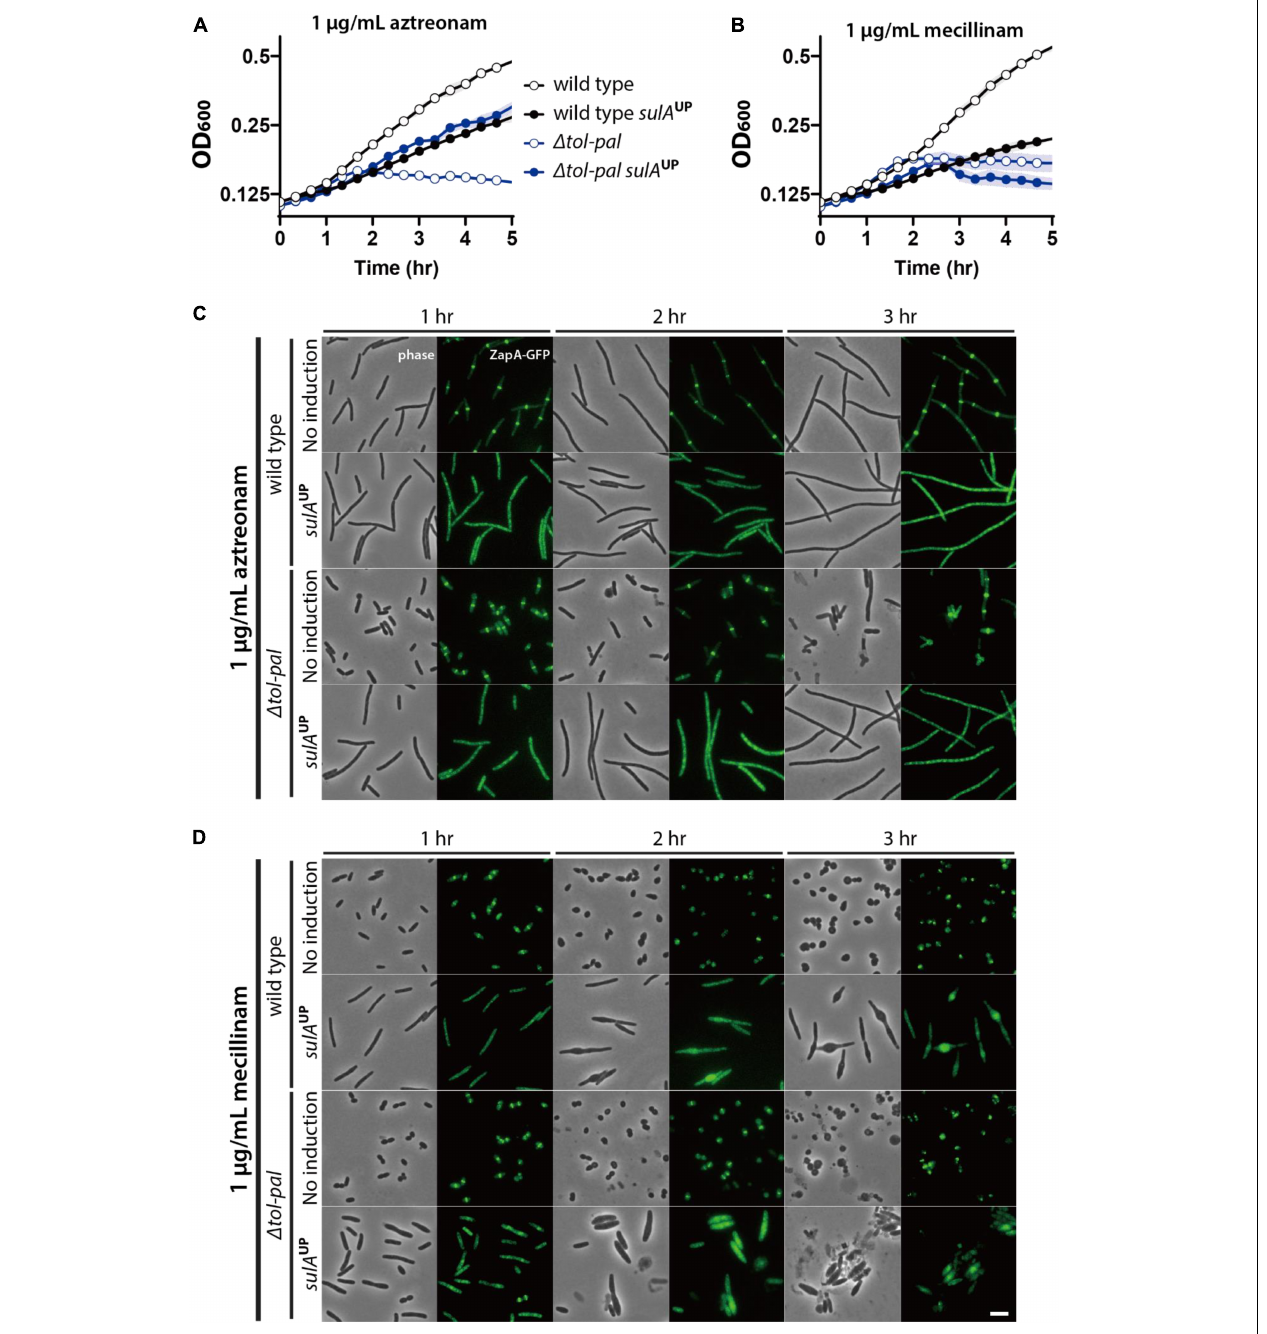
FIGURE 4 | Accelerated lysis of the tol-pal mutant upon mecillinam treatment is not suppressed by inhibiting division. (A,B) SP97 ( zapA-gfp ) and SP98 ( (cid:49) tol-pal , zapA-gfp ) strains harboring pSP6 (P tac : sulA ) were grown overnight in M9 minimal medium supplemented with 0.2% glucose, 0.2% casamino acids (CAA), and 5 µ g/ml tetracycline at 30 ◦ C. The overnight cultures were diluted to an OD 600 of 0.02 in the same medium and grown to an OD 600 between 0.2 and 0.3. Then, cells were washed and diluted in M9-glucose-CAA medium lacking or supplemented with 1 mM IPTG for induction of sulA expression. After induction for 30 min, the cultures were diluted to an OD 600 of 0.1 in the same corresponding media containing either aztreonam (A) or mecillinam (B) at a final concentration of 1 µ g/ml. The optical density of the cultures was measured in the same way described for Figure 1 . (C,D) The same cultures were incubated in test tubes at 30 ◦ C with agitation after dilution in media containing aztreonam (C) or mecillinam (D) . The cell shape and lysis phenotype of the cells in each culture were observed using phase contrast optics at 1–3 h after beta lactam treatment. The effects of sulA induction on division inhibition of the same cells was monitored using ZapA-GFP as a marker for divisome assembly. The discrete bands of fluorescence in the absence of sulA induction represents the assembled divisomes, while diffuse fluorescence signal upon induction of sulA expression indicates inhibition of divisome assembly. The scale bar represents 5 µ m.